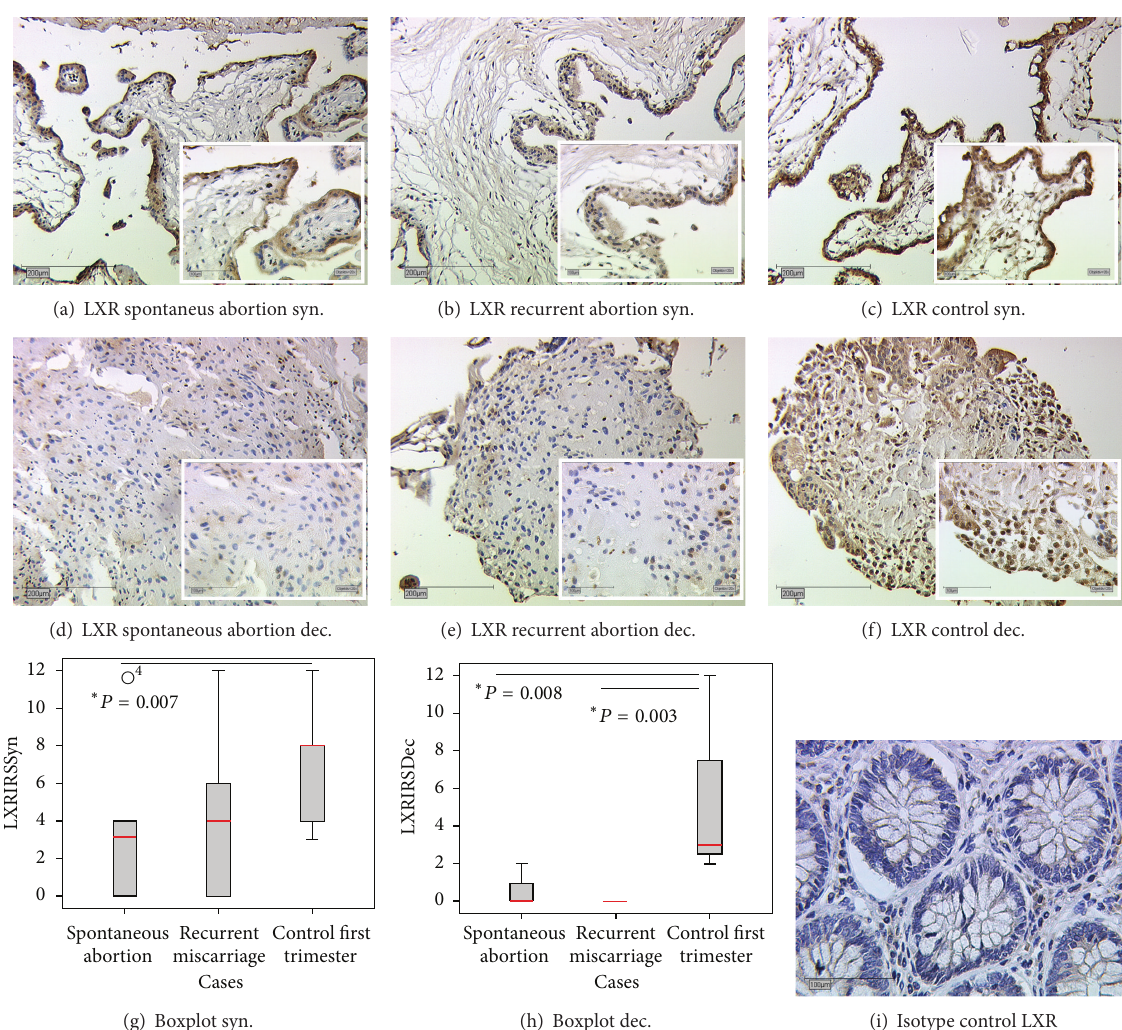
Figure 1: Sections of LXR expression in the syncytiotrophoblast and decidua of placentas from spontaneous abortion ((a), (d)), recurrent miscarriage ((b), (e)), and in regular pregnancies ((c), (f)). (i) shows Isotype control for LXR from colon tissue. Box plots represent the LXR expression in the placental syncytiotrophoblast (g) and decidua (h) of spontaneous abortion, recurrent miscarriages, and control placentas derived immunohistochemically. The boxes display the range between the 25th and 75th percentile and the red horizontal line indicates the median. The bars represent the 5th and 95th percentiles. Circles indicate values which are more than 1.5 times the box length. LXR expression in the syncytiotrophoblast of spontaneous abortion is significantly reduced in comparison to LXR expression in the syncytiotrophoblast of control placentas ( ∗ 𝑃 = 0.007 ). In the syncytiotrophoblast of recurrent miscarriages a downregulation of LXR expression could be detected, however this trend was not significant ( 𝑃 = 0.11 ). In decidua, we identified significant downregulation of LXR in both spontaneous abortion and recurrent miscarriages with 𝑃 values of 0.003 and 0.008, respectively. The Mann-Whitney- 𝑈 test was used for evaluation of two independent